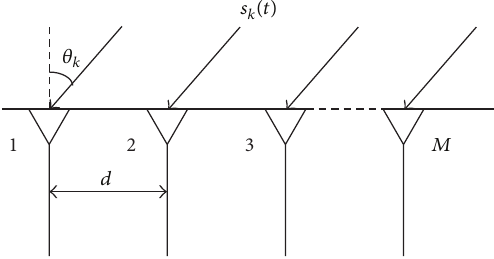
Figure 1: Linear array and far-field